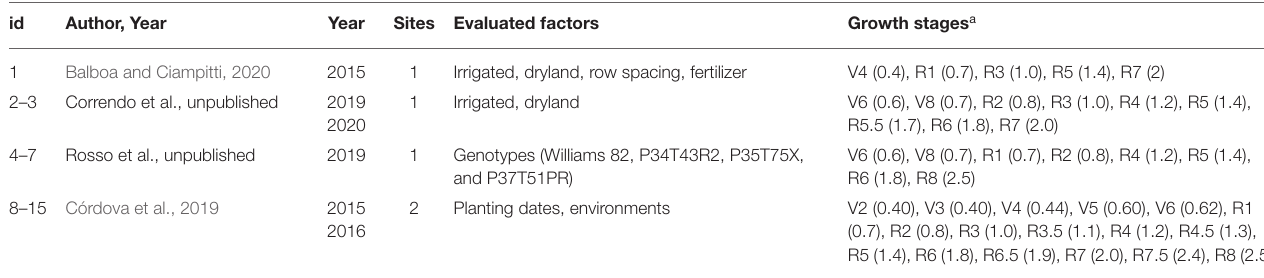
TABLE 1 | Dataset description, study id (unique seasonal curves), author and year of publication, year of the study, number of sites, factors evaluated in the study, timing for data collection, and unique growth